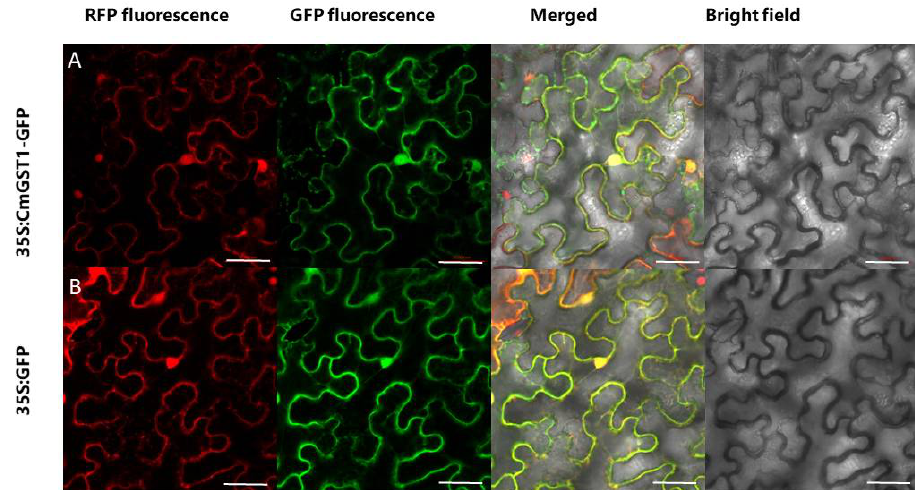
Figure 4. Subcellular localization analysis of CmGST1 in Nicotiana benthamiana . ( A ) Subcellular localization of 35S::CmGST1- GFP together with the vacuolar membrane localization marker (RFP) and nuclear localization marker (RFP). ( B ) Subcellular localization of 35S::GFP as control. Bars = 50 µ